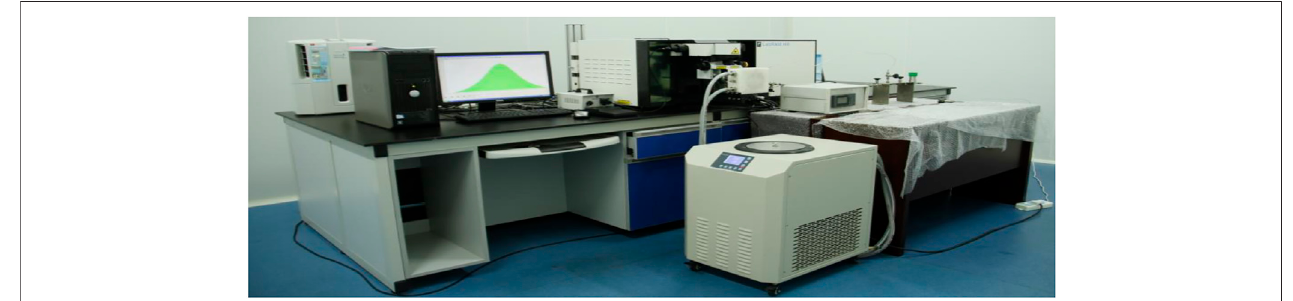
FIGURE 1 | Apparatus for hydrate measurements using in situ Raman spectroscopy.